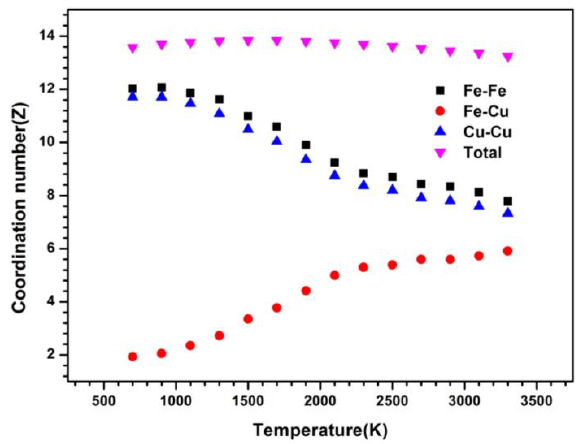
Figure 3. Coordination number versus temperature at a cooling rate of 6.4 × 10 12 K/s.